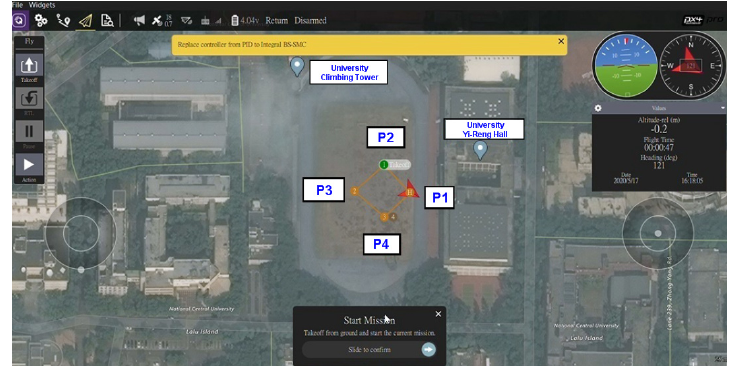
Figure 9. Tracking plan of quadrotor in experiment.